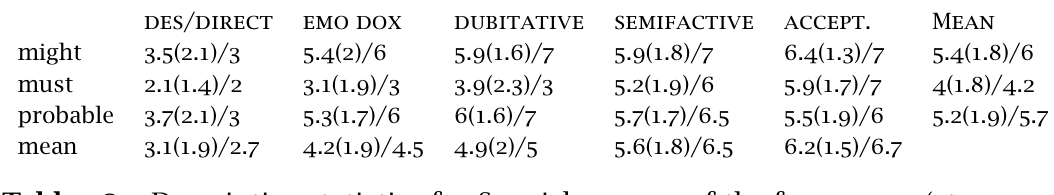
Descriptive statistics for Spanish survey, of the form mean (stan- dard deviation)/median.